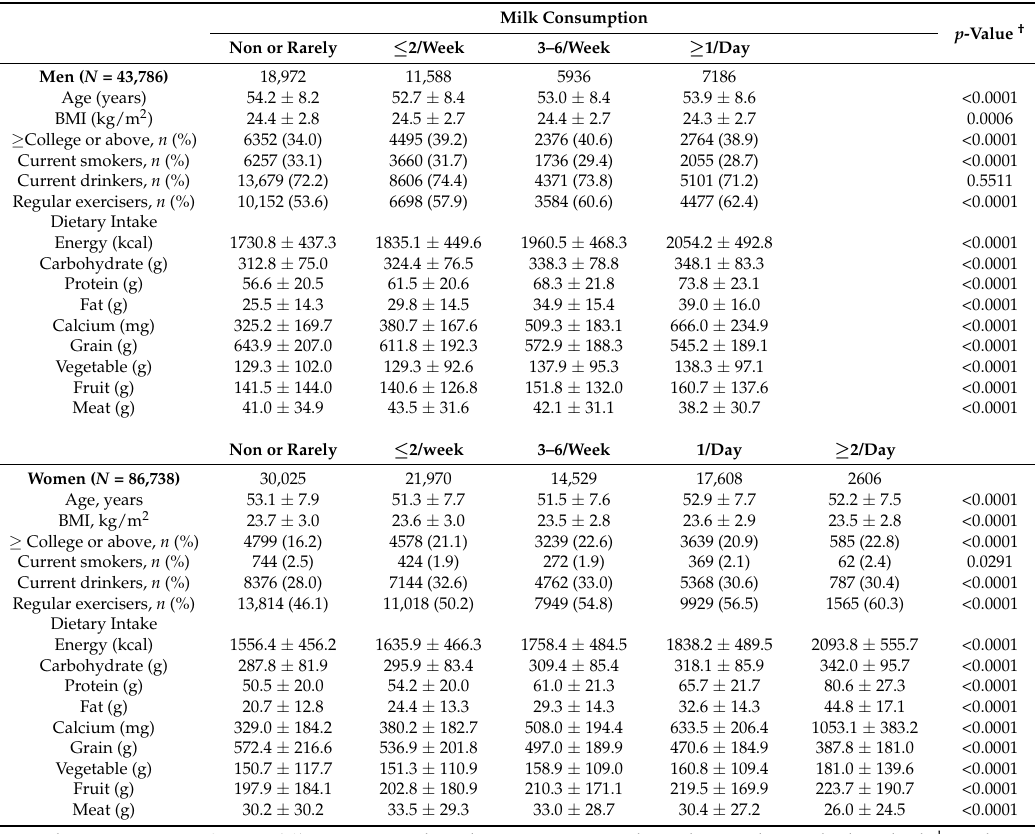
Table 1. Baseline characteristics * by milk consumption, the Health Examinee Study-Gem (HEXA-G) study,